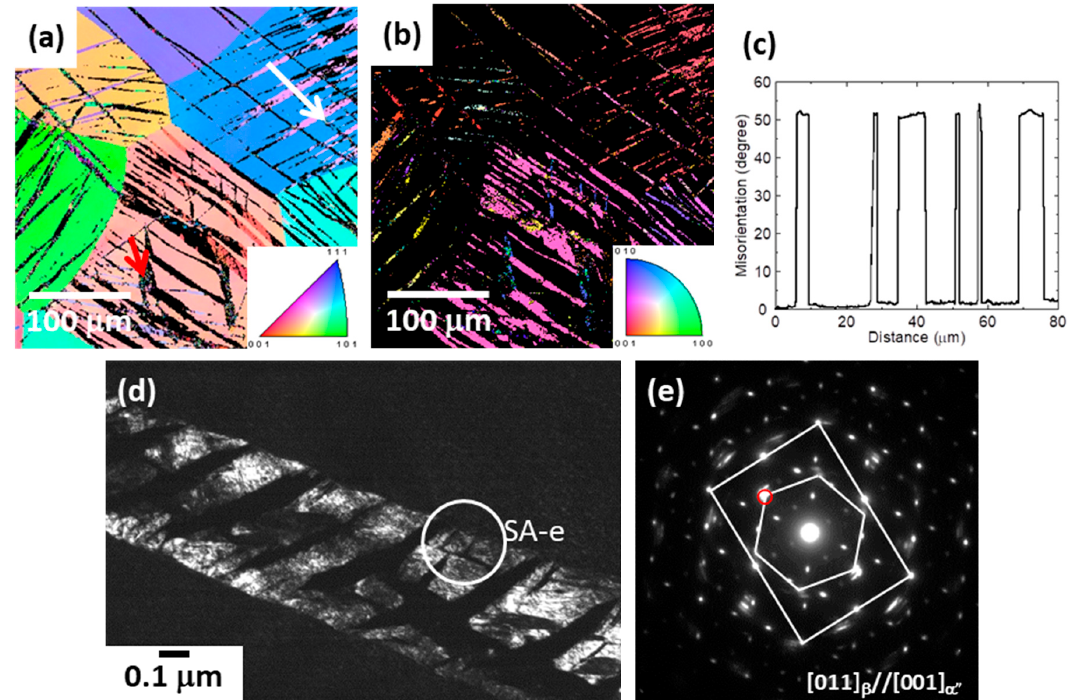
Figure 3. EBSD and TEM analysis of the specimen compressed at a hydrostatic pressure of 2.5 GPa: ( a ) EBSD inverse pole figure map of β phase, ( b ) EBSD inverse pole figure map of SIM α″ phase, ( c ) line traces across the region indicated by white arrows in ( a ) showing the misorientation angle, ( d ) dark field image of SIM α″ phase and ( e ) the corresponding SAED pattern.